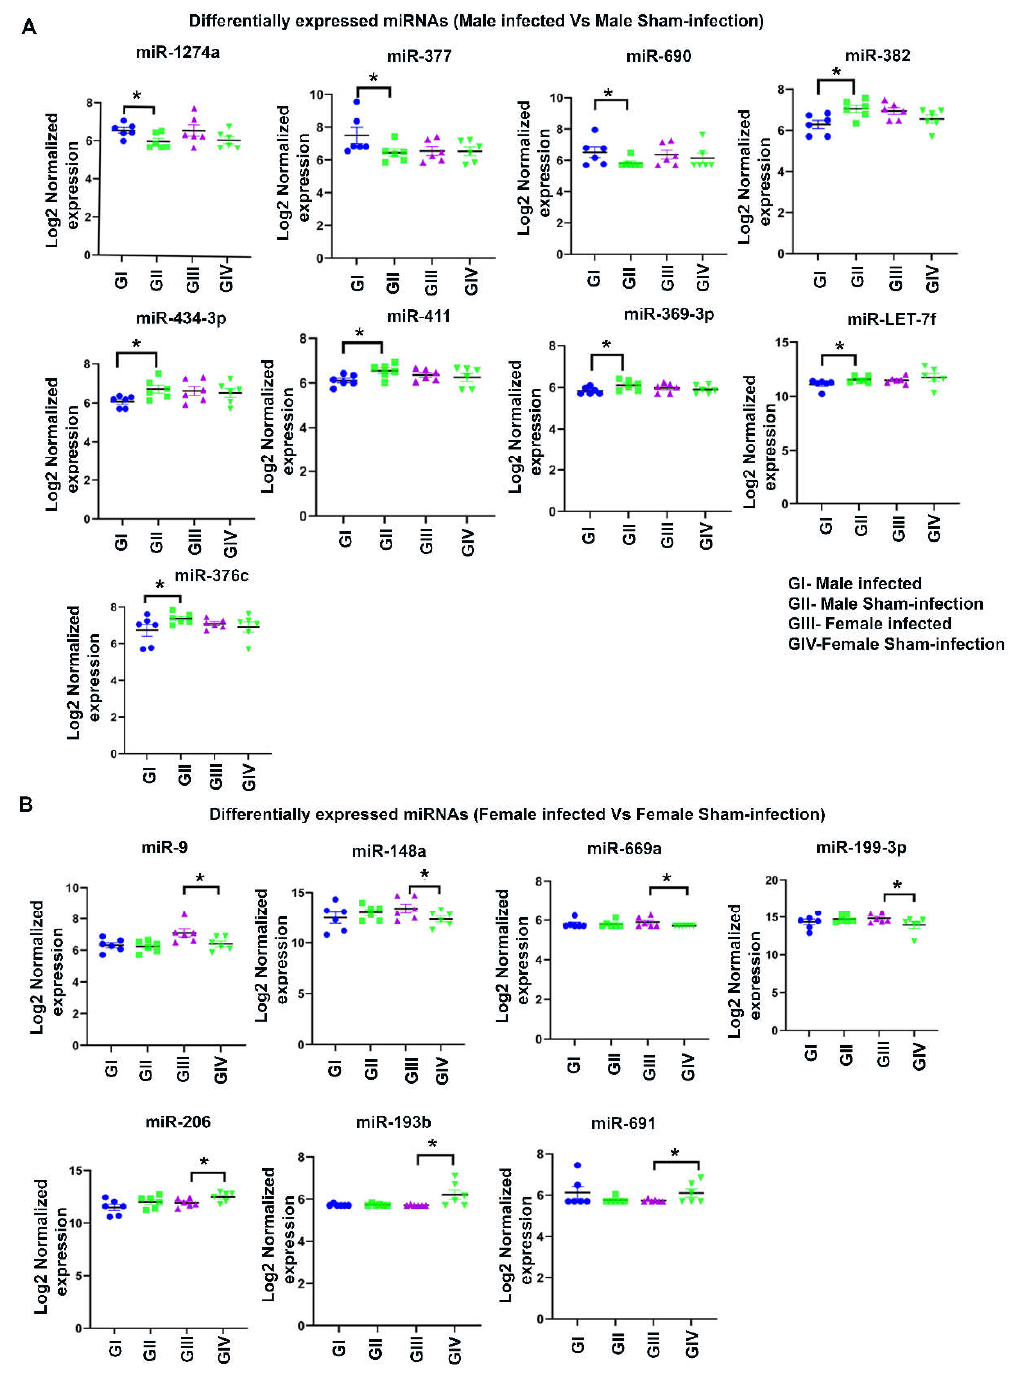
Figure 4. Differentially expressed miRNAs in male and female mice infected with partial human mouth microbes (PAHMM) compared to sham-infected mice. ( A ) Both upregulated miRNAs (miR- 1274a, miR-377, and miR-690) and downregulated miRNAs (miR-382, miR-434-3p, miR-411, miR- 369-3p, miR-LET-7f, and miR-376c) in male mice infected with PAHMM showed a fold difference of ± 1.1 with p FDR of < 0.1. The log2-normalized expression of each miRNA is shown on the y -axis, and the details of the group are shown on the x -axis. ( B ) Both upregulated miRNAs (miR-9, miR-148a, miR-669a, and miR-199-3p) and downregulated miRNAs (miR-206, miR-193b, and miR-691) in female mice infected with PAHMM showed a fold difference of ± 1.1 with p FDR of < 0.1. The log2-normalized expression of each miRNA is shown on the y -axis, and the details of the group are shown on the x -axis (* p FDR < 0.1; n =